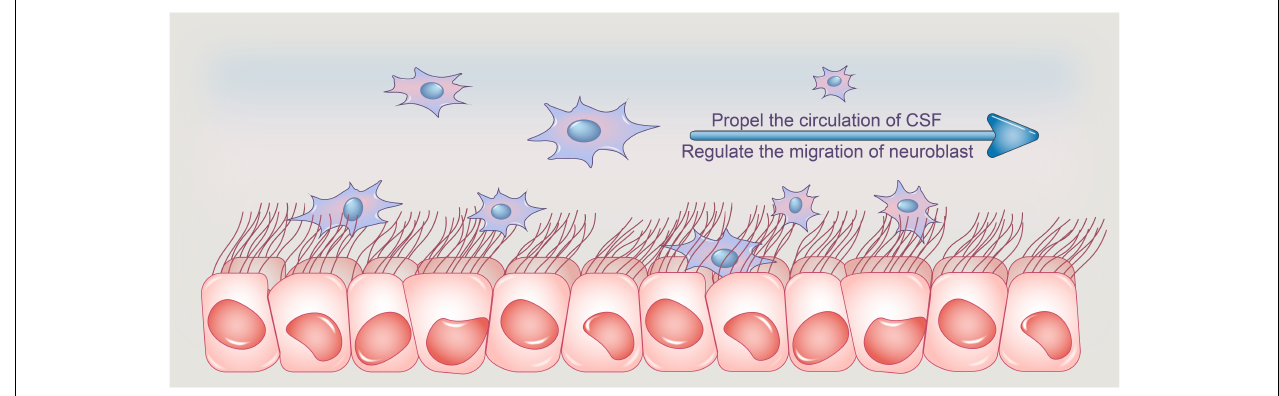
FIGURE 1 | Functions of ependymal cilia. Ependymal cilia protrude from ependymal cells, and their synchronized pulsing transports CSF from the lateral ventricle to the third and fourth ventricles, where it is absorbed. Adult ependymal cells’ apical enrichment of actin in centriolar plaques aids in the maintenance of the optimal number and spacing of centrioles, allowing ependymal cells to maintain an ideal number of motile cilia and thus aid in CSF nutrition exchange and waste clearance, assisting in CSF homeostasis. Furthermore, the beating of ependymal cilia can propel CSF flow and create a concentration gradient of guiding molecules, which aids neuroblast migration orientation. CSF, cerebrospinal